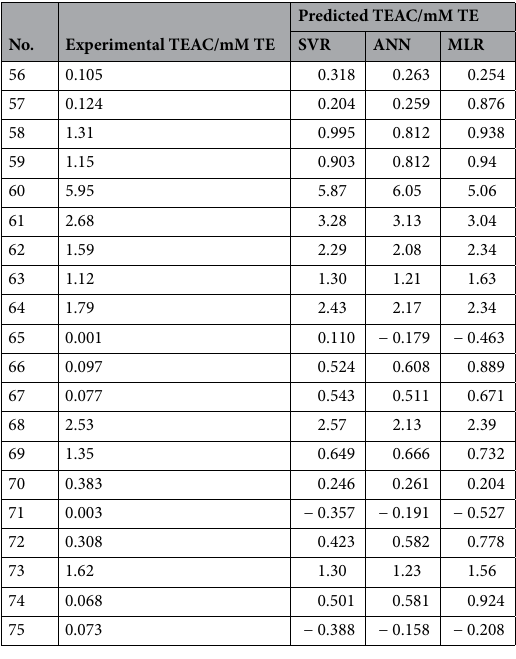
Table 2. Predicted TEAC with different methods using LOOCV (No. 1–57) and test set (No. 58–75).